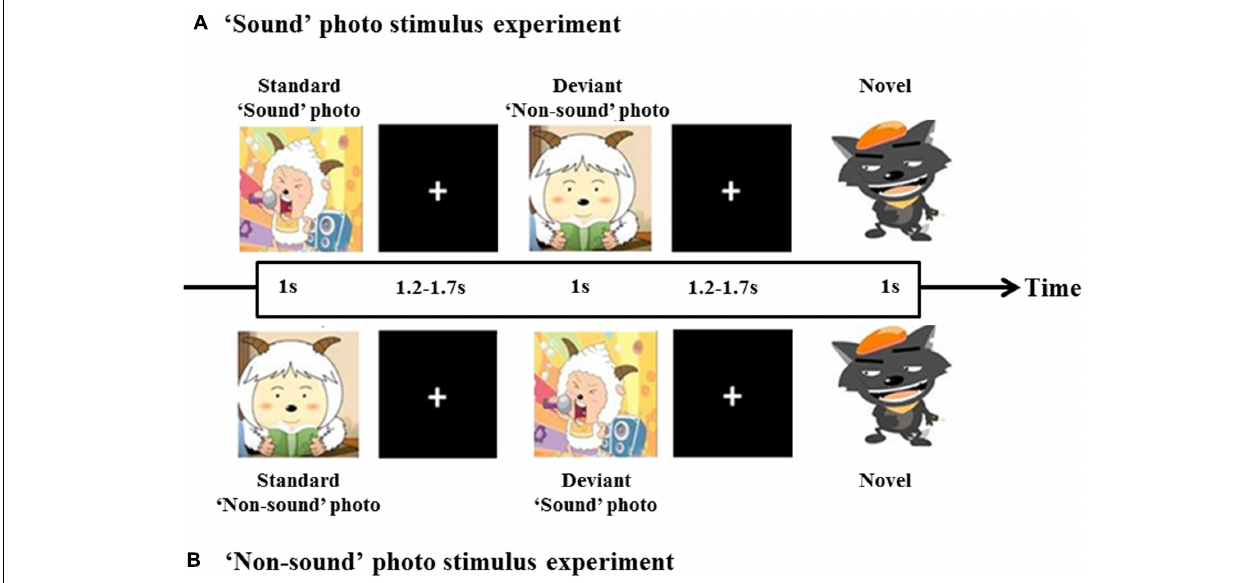
FIGURE 1 | Diagram of the experimental block design. A total of 100 stimuli, 85% for standard and 15% for deviant. At least one standard stimulus was presented before each deviant stimulus was given. ‘Sound’ photo (A) and ‘Non-sound’ photo (B) stimulus